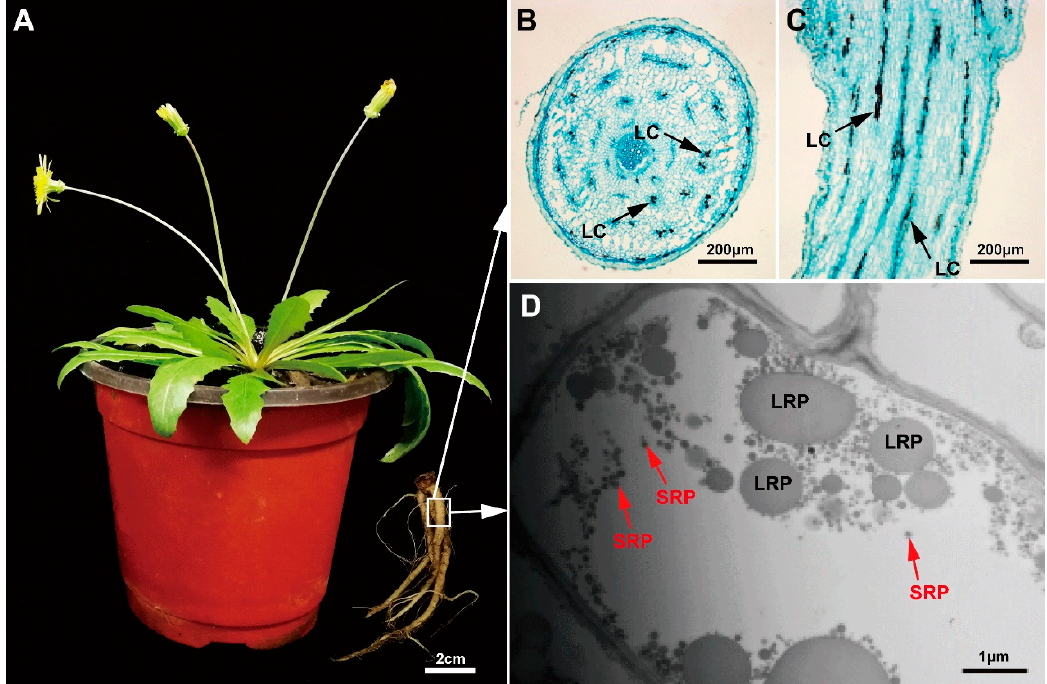
Figure 1. Morphological observation of the laticifer cells and rubber particles in the main roots of Taraxacum kok-saghyz (TKS). A six months old TKS plant and its main roots are highlighted ( A ). The laticifer cells containing brown rubber can be examined under the crosscutting ( B ) and slitting ( C ) slices of the 6M TKS roots. Black arrows indicate the positions of typical laticifer cells. Both small rubber particles (SRP) and large rubber particles (LRP) in the main roots of 6M TKS can be observed under a transmission electron microscope (TEM) ( D ).